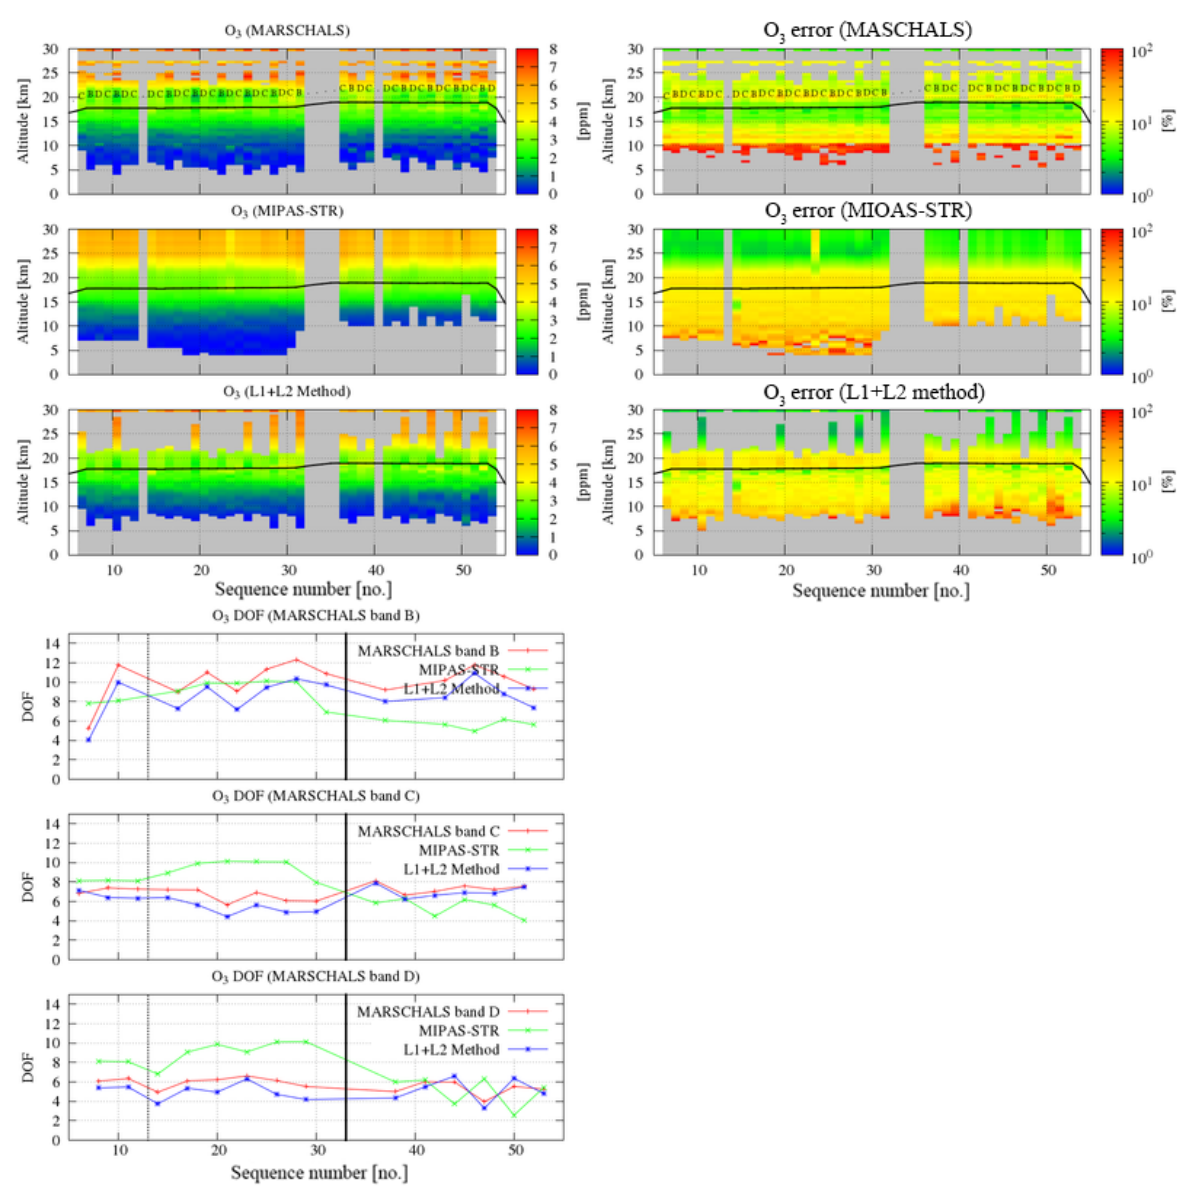
Figure 10. O 3 retrieved results obtained from initial analyses and (L1 + L2) data fusion of MARSCHALS and MIPAS-STR limb sounding observations: vertical profiles (top left panel), total relative error profiles (top right panel) and number of DOF (bottom